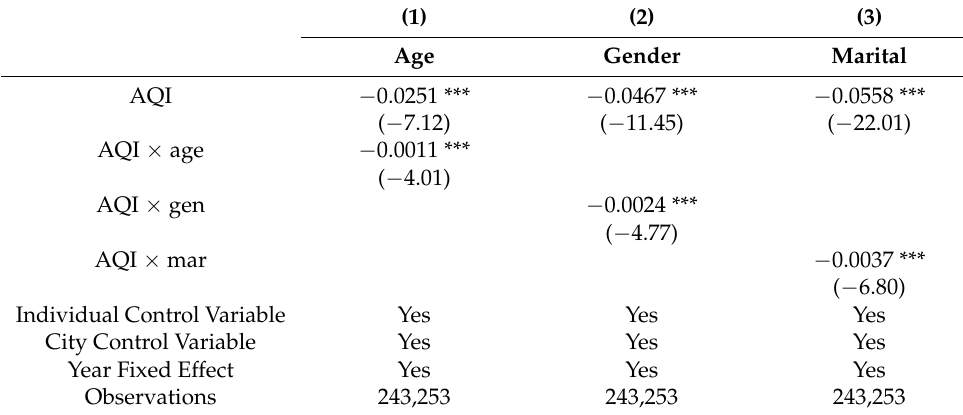
Table 5. The impact of air pollution on heterogeneous